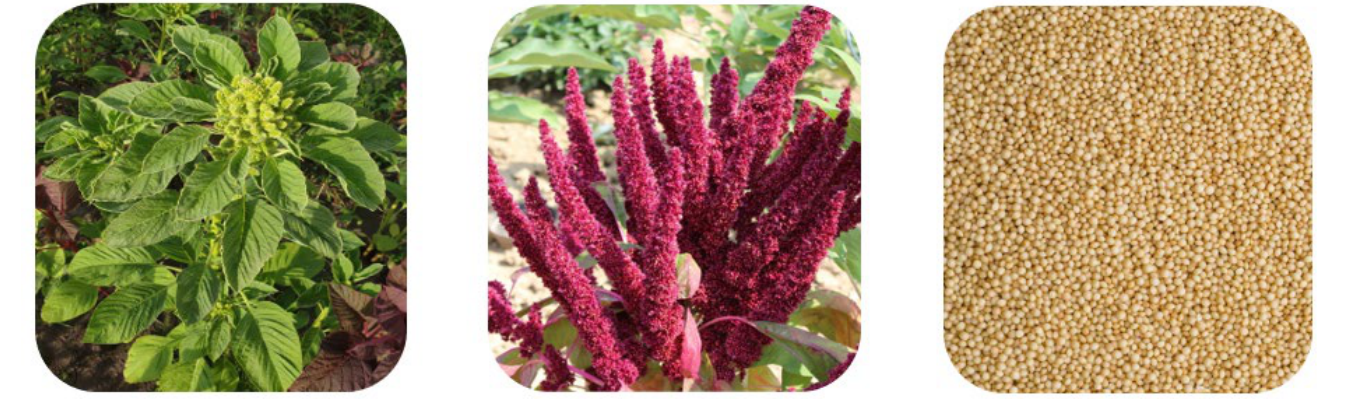
Figure 3. Plant, flowers, and seeds of